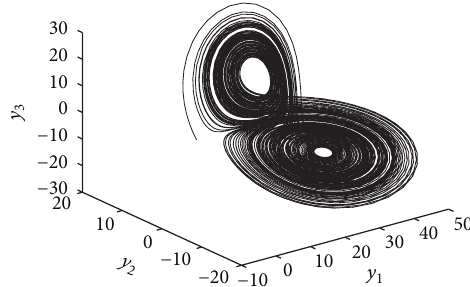
Figure 1: Dynamic behavior of the chaotic system in case